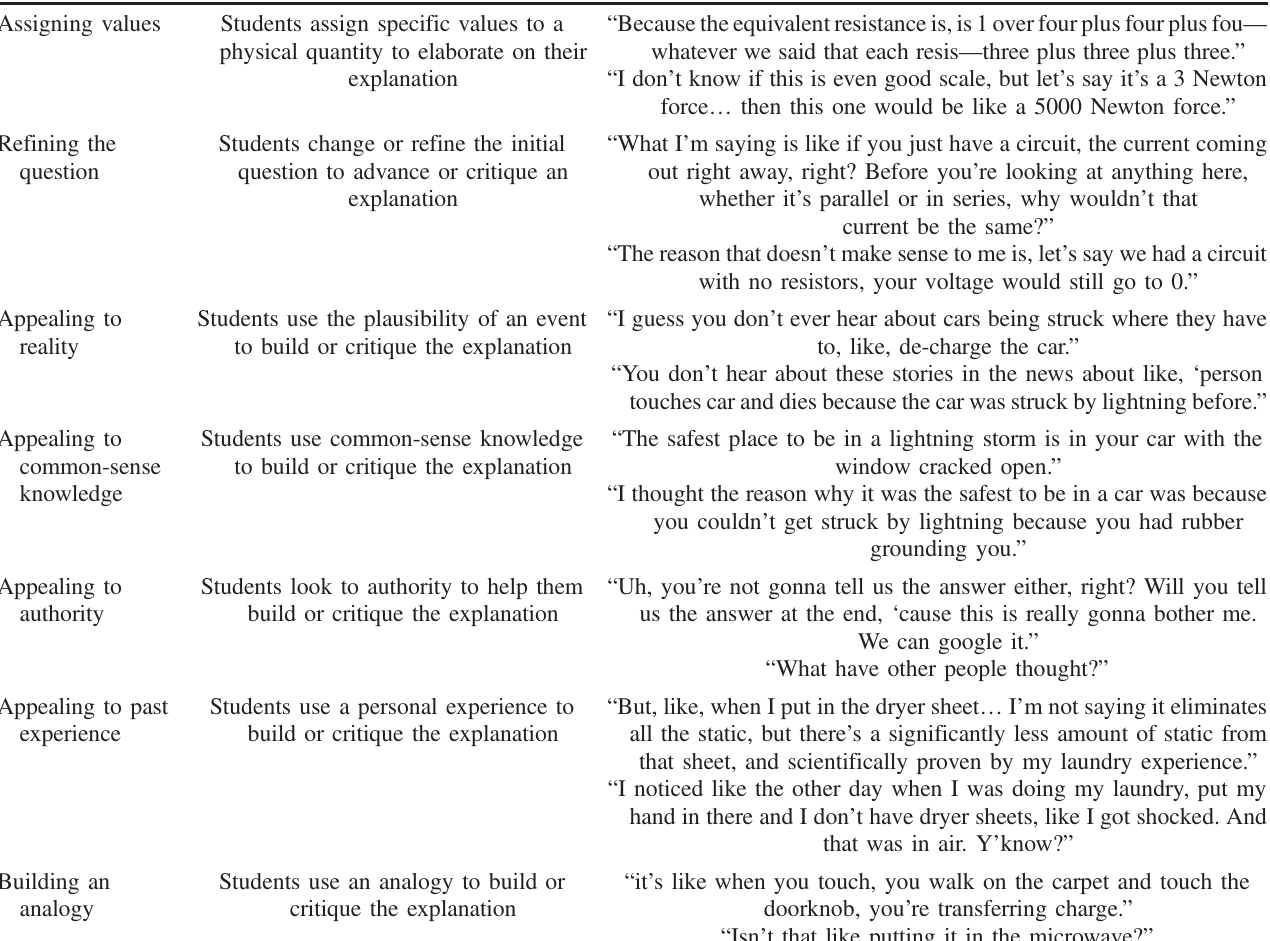
TABLE III. Moves from the sensemaking epistemic